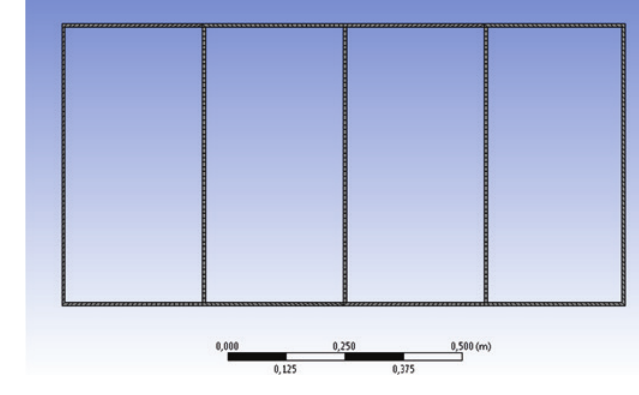
Figura 10 Malha da estrutura para o problema